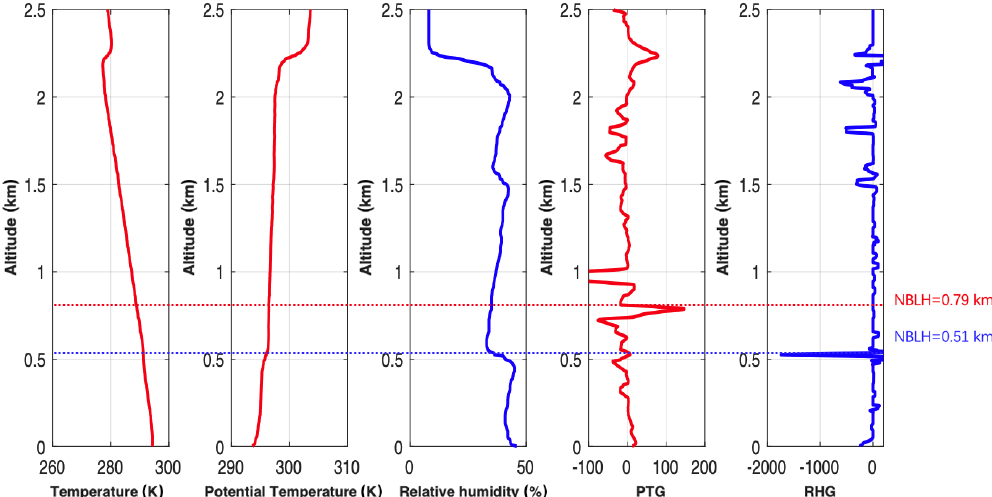
Figure 11. Planetary boundary layer height estimates using radiosondes. Profiles include temperature, potential temperature, relative humid- ity, potential temperature gradient (PTG), and relative humidity gradient (RHG). Estimated NBLH by PTG (red) and RHG (blue) are shown by dashed horizontal lines at 20:00LST.